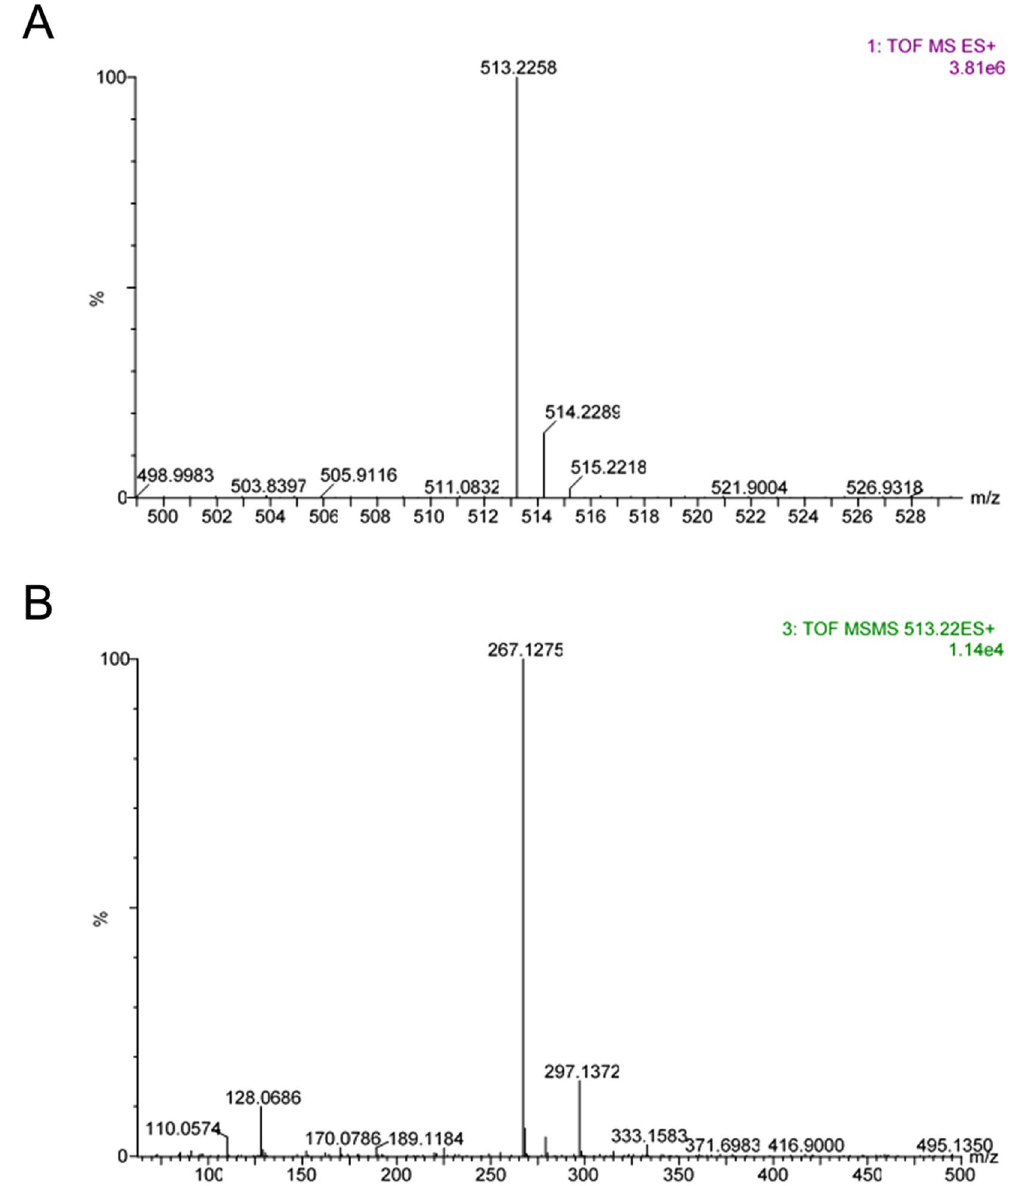
Figure 6. LC-TOF–MS analysis of the LMW MAGEs. ( A ) Mass spectrum of the major ion with m/z 513 and ( B ) its MS/MS fragmentation